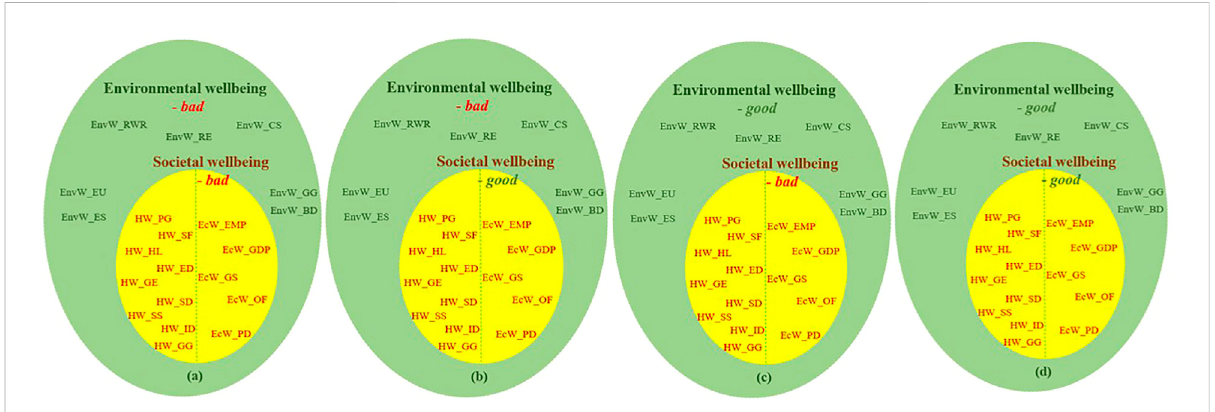
FIGURE 5 Egg of wellbeing (adapted after Prescott-Allen, 2001, p. 5). (A – C) emphasize an unwell and unsustainable society, while (D) emphasizes a sustainable society.